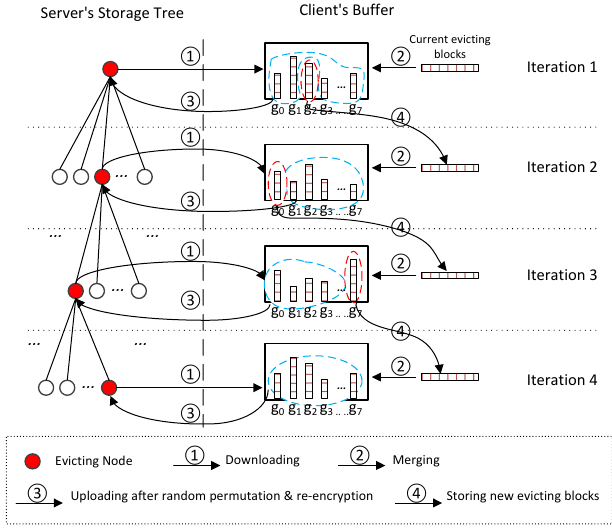
Figure 5. Eviction